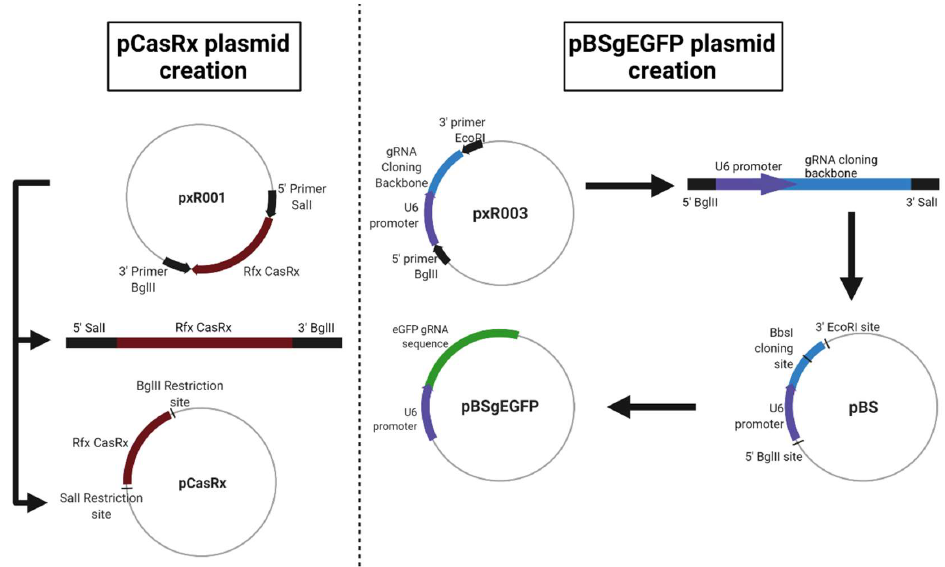
Figure 5. Schematic representation for the construction of each newly created plasmid. Created with Biorender.com. (accessed on 24 August